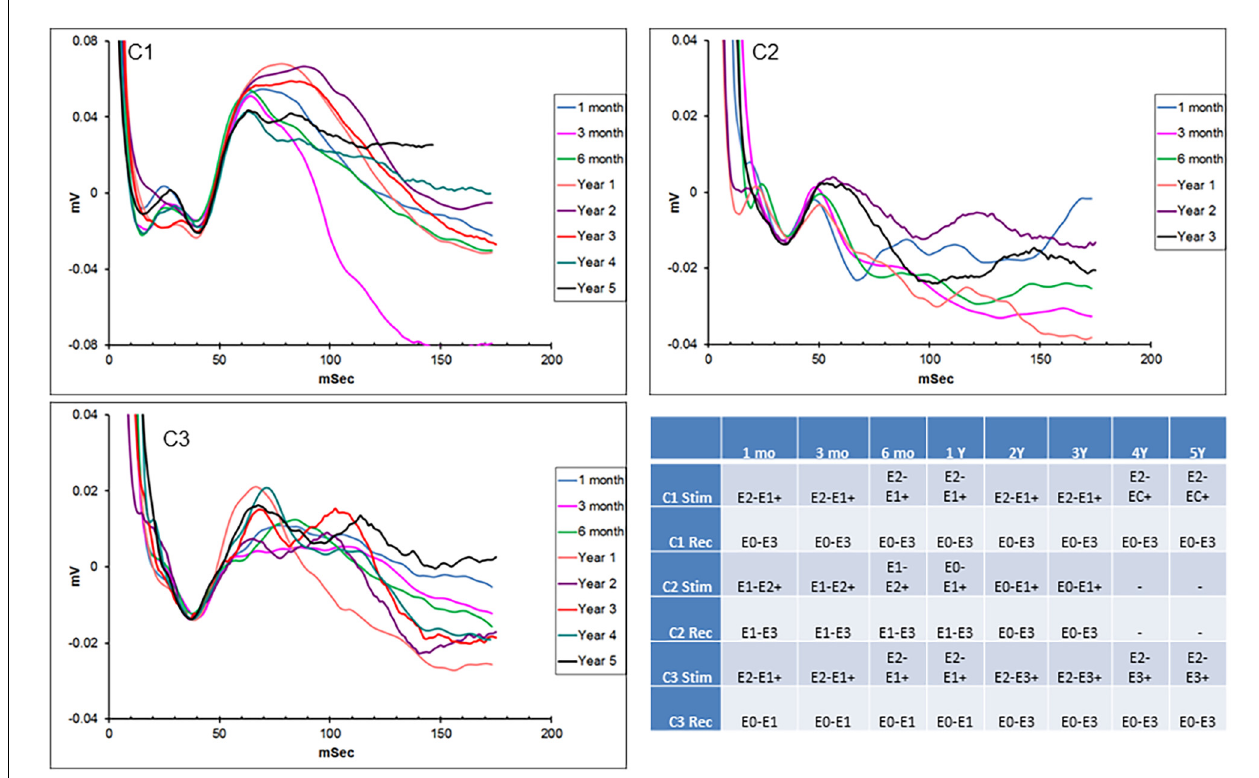
FIGURE 2 | Chronic hippocampal evoked responses. Evoked potentials (EPs) recorded at multiple time points from the three subjects in response to anterior nucleus (AN) stimulation. Slight changes in electrode contact pairs were made in some cases due to lead breakage or possible electrode shift over time. Subject C1: recording (HC E0-E3), stimulation (AN E2-E1+, 5 V; AN E2-C+, 1.5 V); subject C2: recording (HC E1-E3/E0-E3), stimulation (AN E1-E2+; E0-E1+, 5 V); subject C3: recording (HC E0-E1/E0-E3), stimulation (AN E2-E1+, E2-E3+, 5 V). HC,